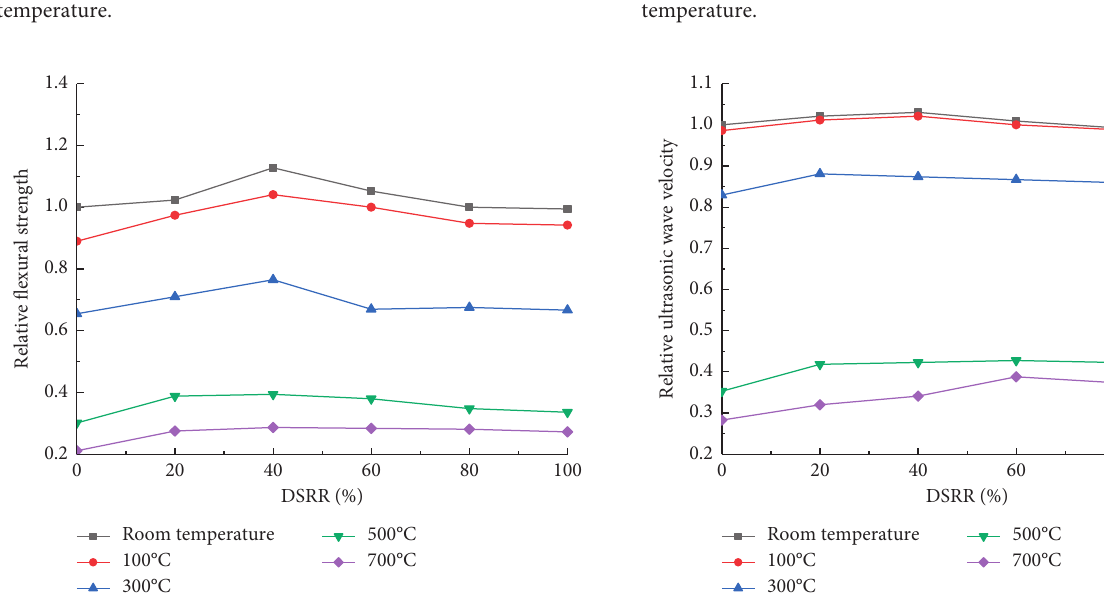
Figure 16: Relation between relative flexural strength and DSRR.